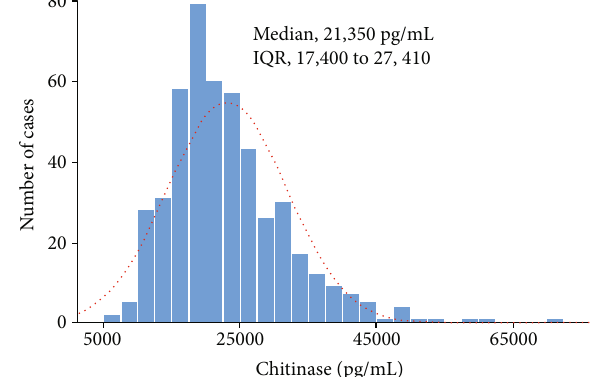
Figure 1: Serum concentrations of YKL-40 in the study population ( n = 479